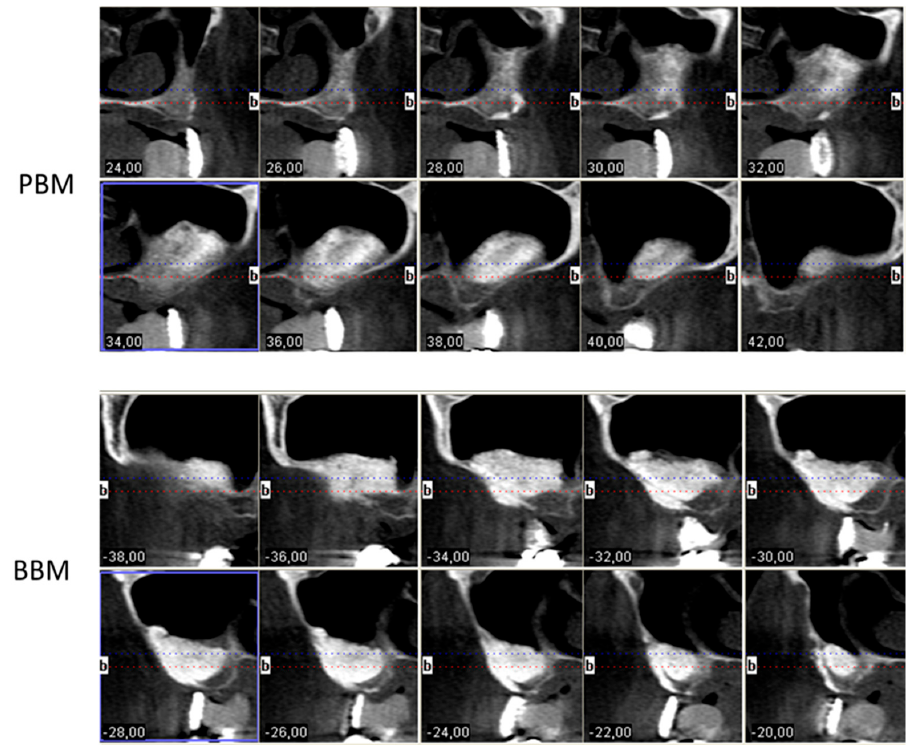
Figure 2. The i-CAT Vision postoperative image shows the increased volumes produced by the xenograft procedures 6 months after maxillary sinus elevation with a porcine hydroxyapatite (axial cuts 24–42) and a bovine hydroxyapatite (axial cuts − 38 to − 20)( b = Buccal side).